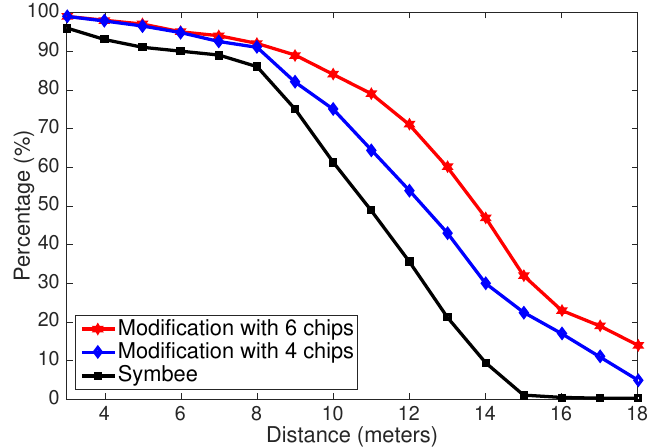
Figure 13. CTC bits accepted ratio.